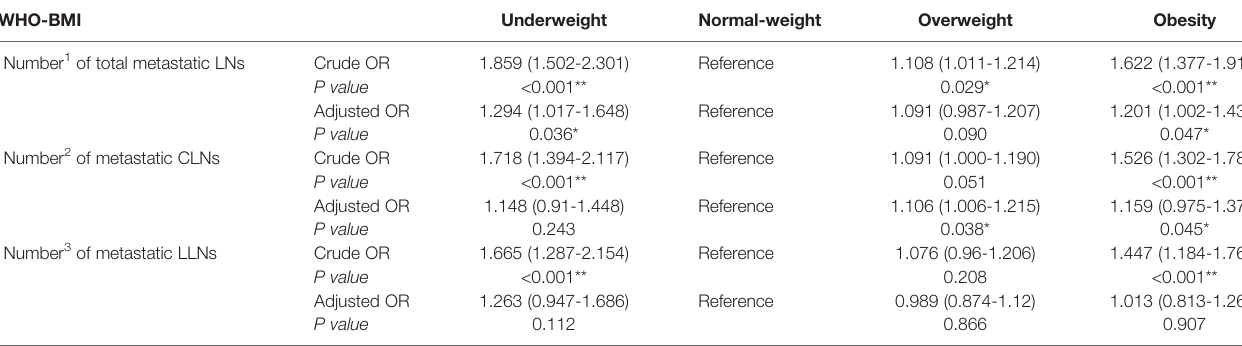
TABLE 5 | Binary logistic regression analyzed the relationship between BMI and the number of metastatic LNs. WHO-BMI